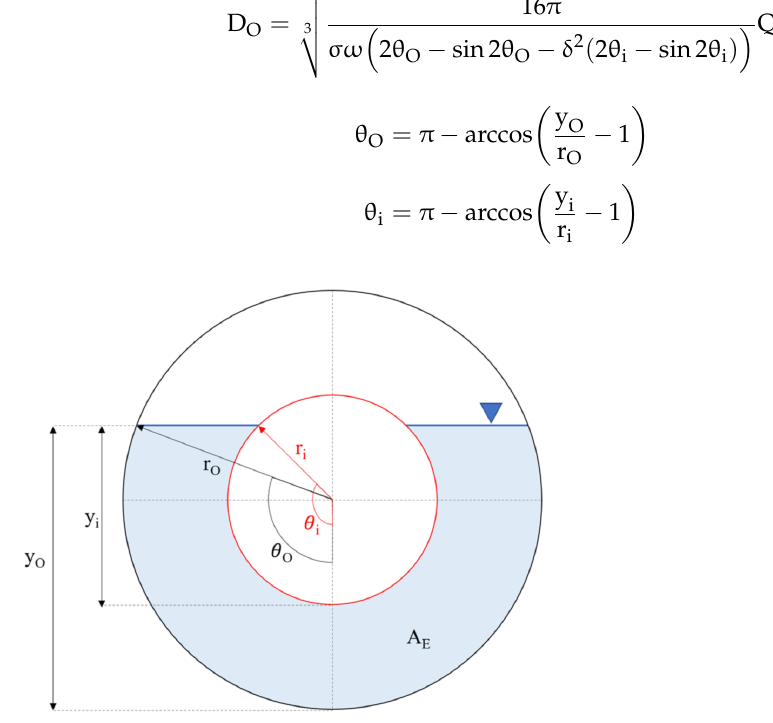
Figure 7. Parameters to define A E